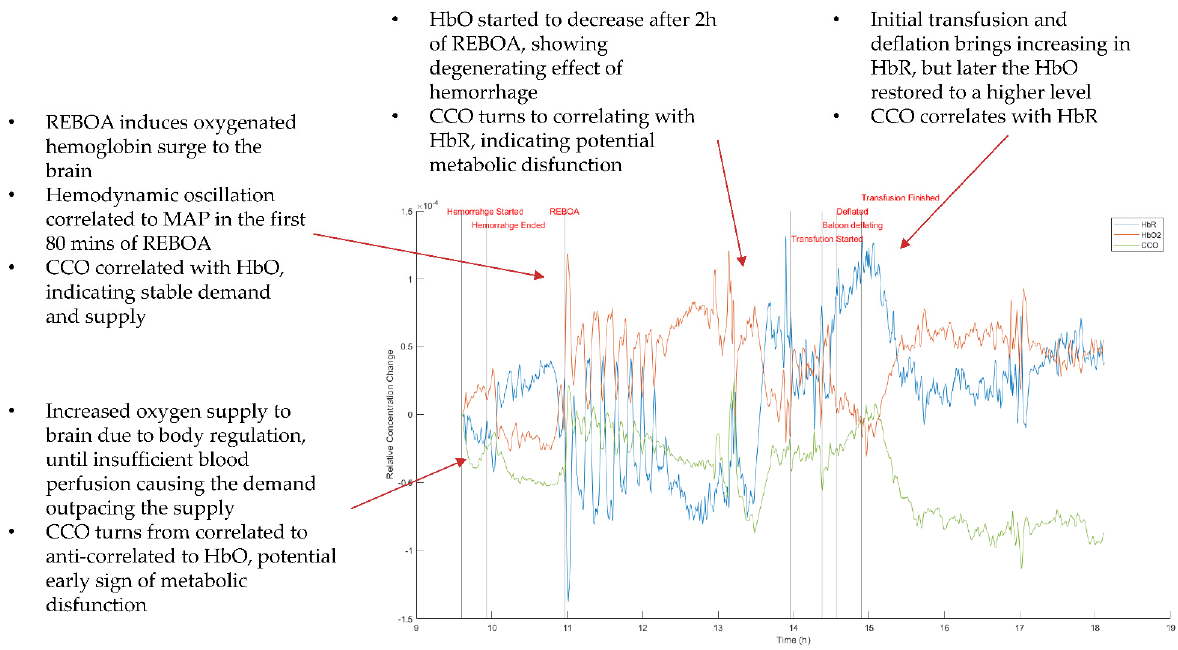
Figure 34. HbO, HbR, and CCO concentration changes during pREBOA-only swine HS test.